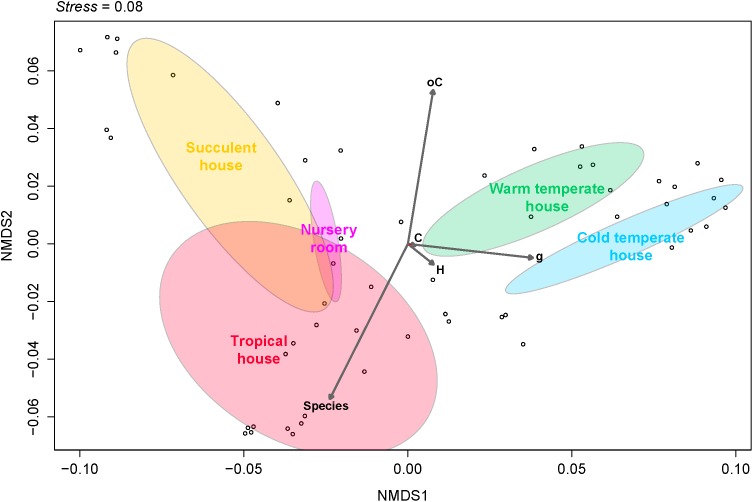
Non-metric multidimensional scaling (NMDS) plot derived from Bray-Curtis dissimilarities illustrating distances between fungal community compositions. The BIO-ENV vectors of environmental variables based on Euclidean distances represent the direction along the samples of each greenhouse room, showing the role each of them played in explaining the distribution of the samples and its directional influence. Species, plant species; H, relative humidity inside the room; C, temperature inside the room; oC, temperature outside the room; g, leaf weight.